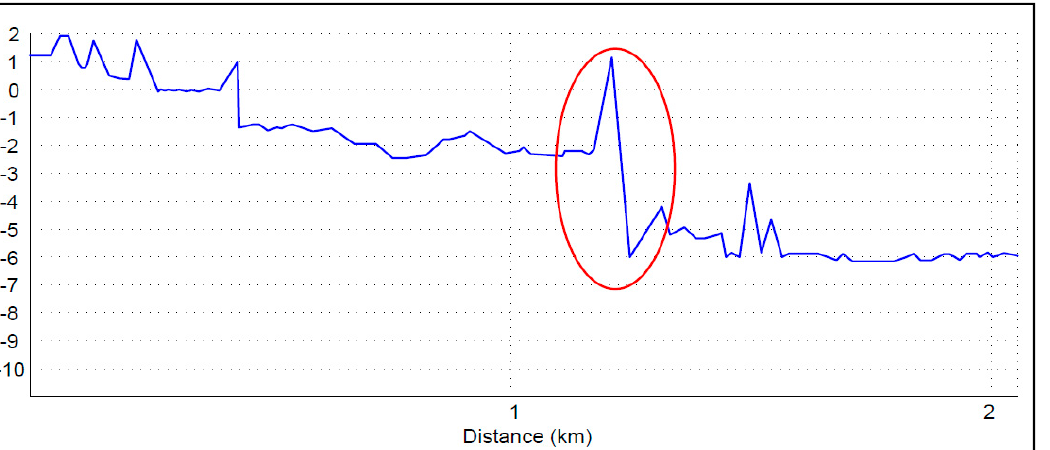
− 1.4 dB Figure 11. The improving FPMT circuit detected a mismatch between fiber cable patterns at event 5. Event 6). A fiber bending is produced in the implemented network at distances of 0.5 km, 0.6 km, 0.7 km, 1.2 km, and 4 km, respectively, and the improved FPMT approach integrated with the EDFA board is applied to detect defects. According to the practical data in Figure 12, the reflection peak is around 0.5 km, 0.6 km, 0.7 km, 1.2 km, and 4 km, respectively, the reflection rate is around − 2 dB, − 3 dB, − 4 dB, − 3 dB, and − 7 dB, respec-